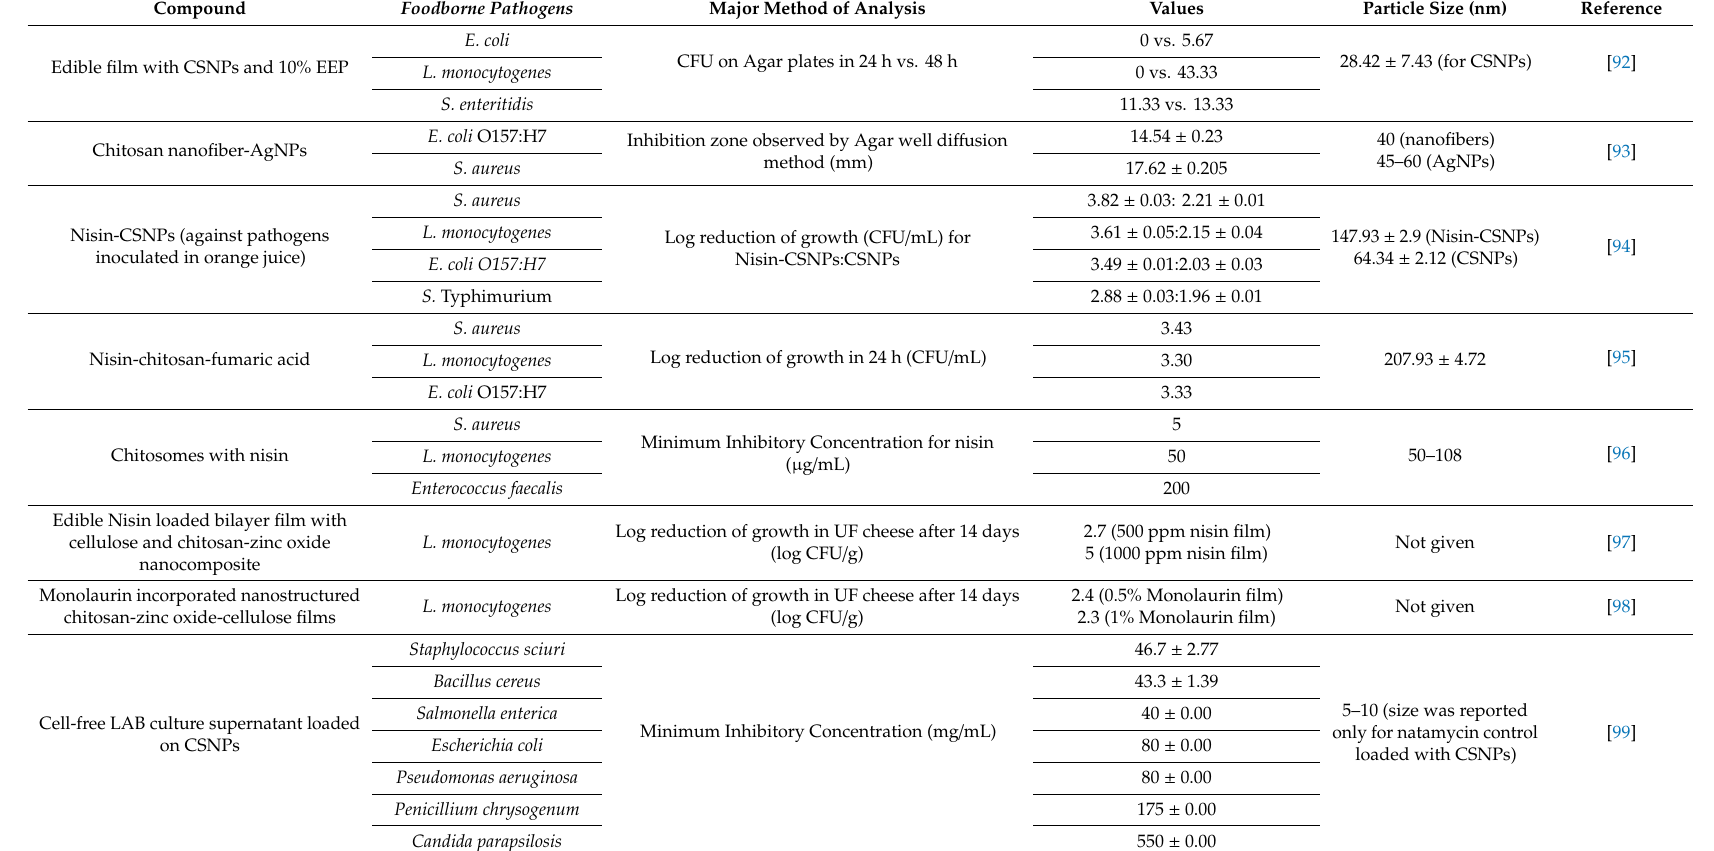
Table 4. Use of chitosan nanoparticles together with natural antimicrobial agents to control foodborne pathogens (MIC: minimum inhibitory concentration, MBC: minimum bactericidal